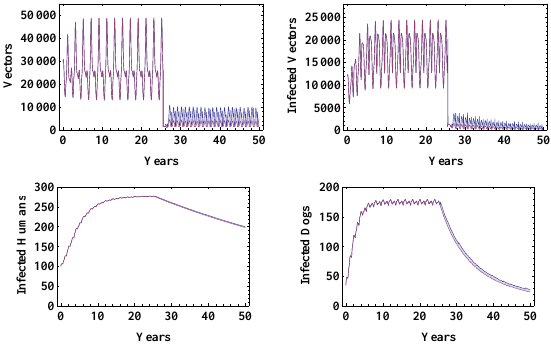
Fig. 3. Case (ii): Model behavior with variability in t 1